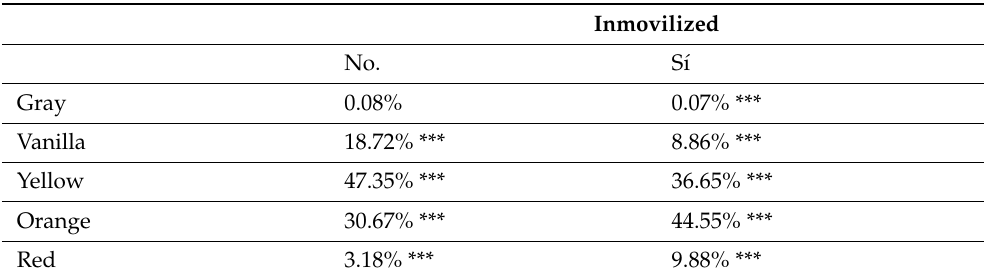
Table 3. Persons over 65 years of age living alone with some type of immobilization according to the color of the patient’s AMG triangle in Drago. Basic Health Areas of Gran Canaria. 2018–2020. (Percentages—%).